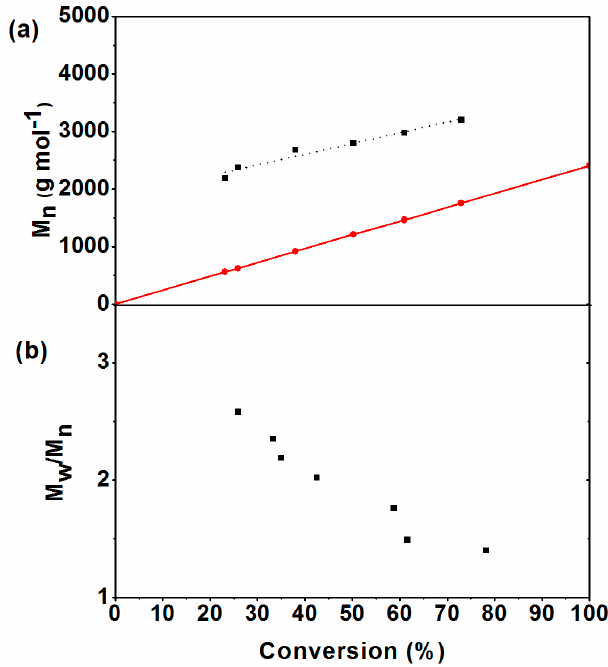
Figure 6. Degenerative iodine transfer polymerization of n - BA with molar ratio of [ n - BA]/[ACPO]/[DIX] = 16/0.08/1 at 60 °C for different times. Dependence of ( a ) molecular weight and ( b ) molecular weight distribution on the conversion of n -BA. The line with solid circles presents the theoretical number-average molecular weight; and the line with solid squares is the molecular weight obtained by GPC in (a). Table 3. Conditions and results obtained from DITP of n -BA at 60 ◦ C for 24 h.